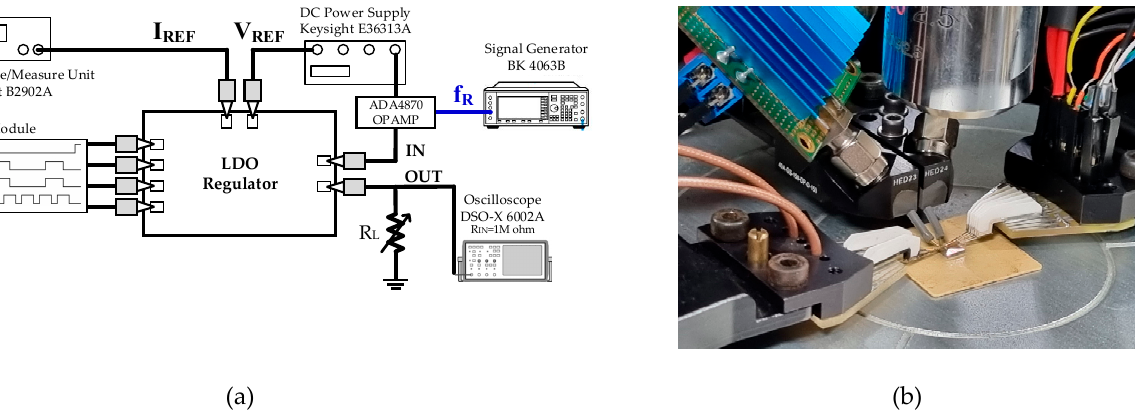
Figure 10. ( a ) Schematic diagram of the PSRR measurement setting and ( b ) a photograph of the measurement setting.